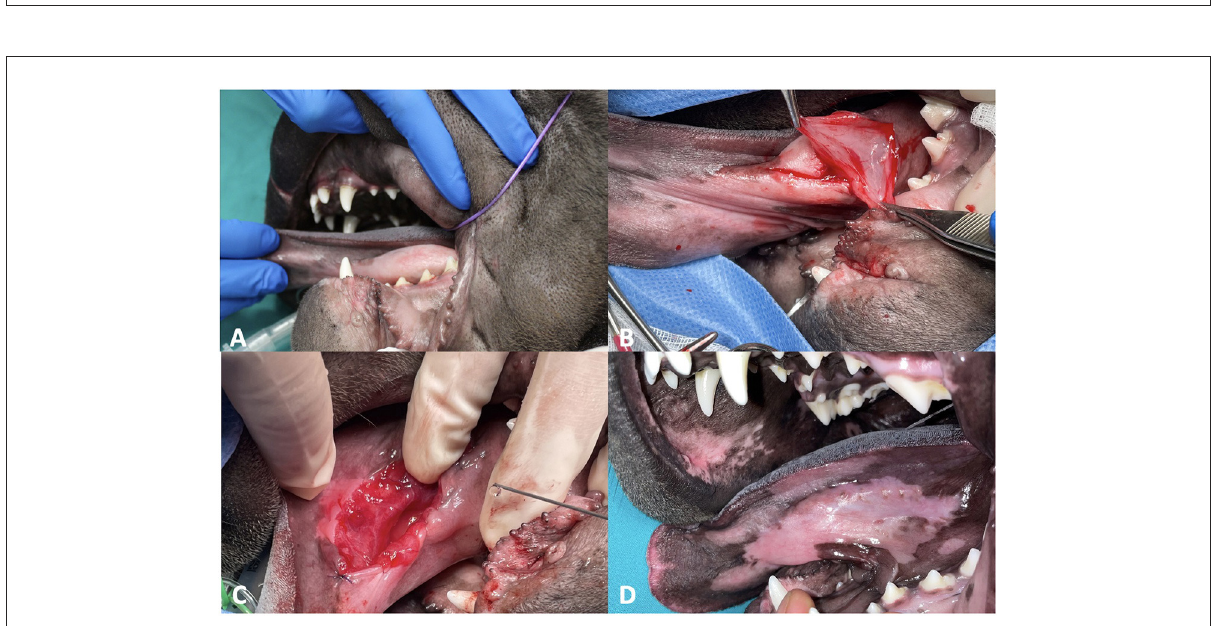
FIGURE3 Left sublingual swelling at presentation. (A) Presence of gelatinous tissue visualized after removing portion of mucosa. (B) Marsupialization with absorbable monofilament suture 4–0 USP. (C) Complete healing 1 month after surgery. (D)